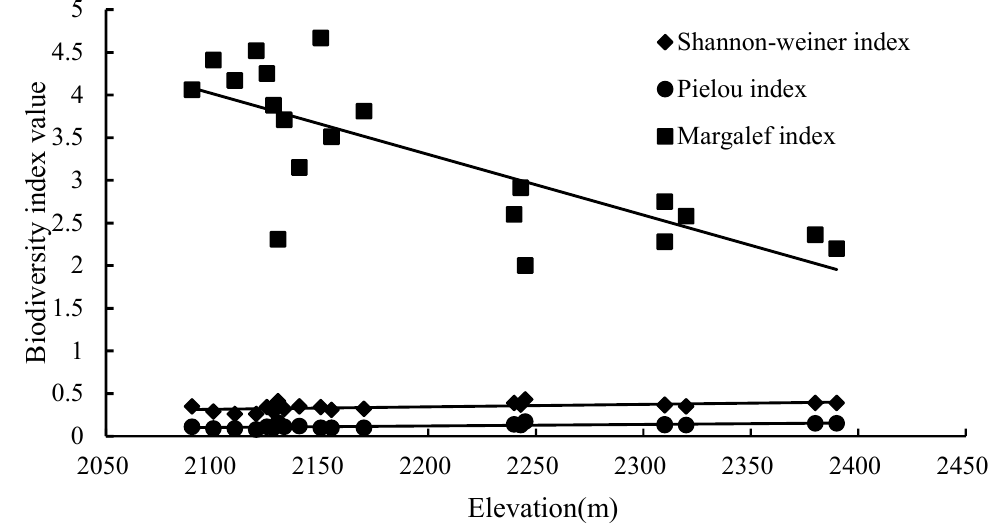
Figure 5. Relationship between biodiversity index and elevation.